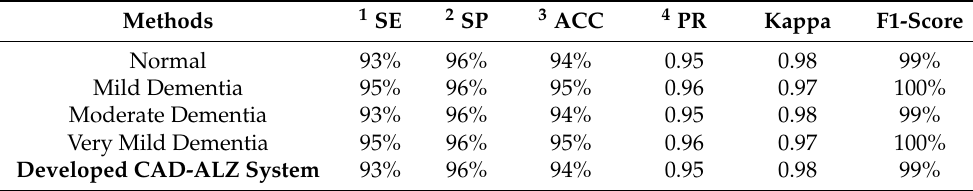
Table 5. Assessment of the result of the developed CAD-ALZ system.